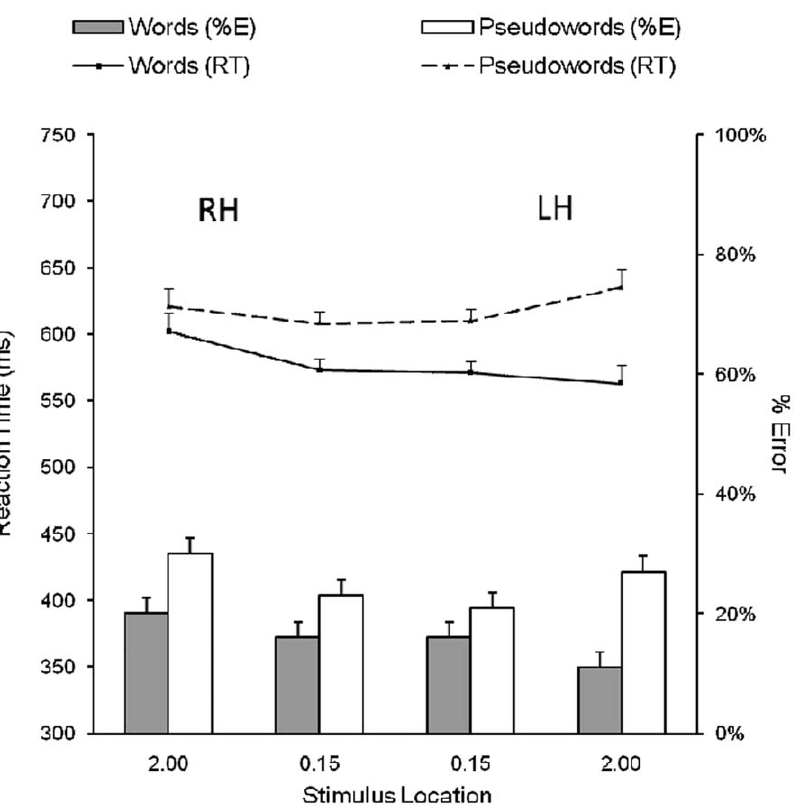
Figure 3. Results for Experiment 2. Footnote: Mean reaction times for correct responses and error rates for Arabic words and pseudowords displayed at foveal and extrafoveal locations in Experiment 2. Bars correspond to 95% confidence intervals [78]. The terms RH and LH refer to the hemisphere contralateral to the hemifield in which stimuli were presented.